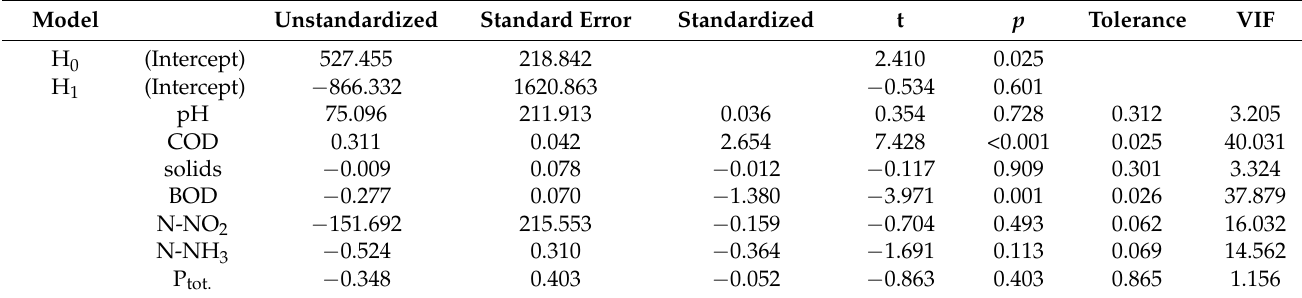
Table 8. Model coefficients with collinearity